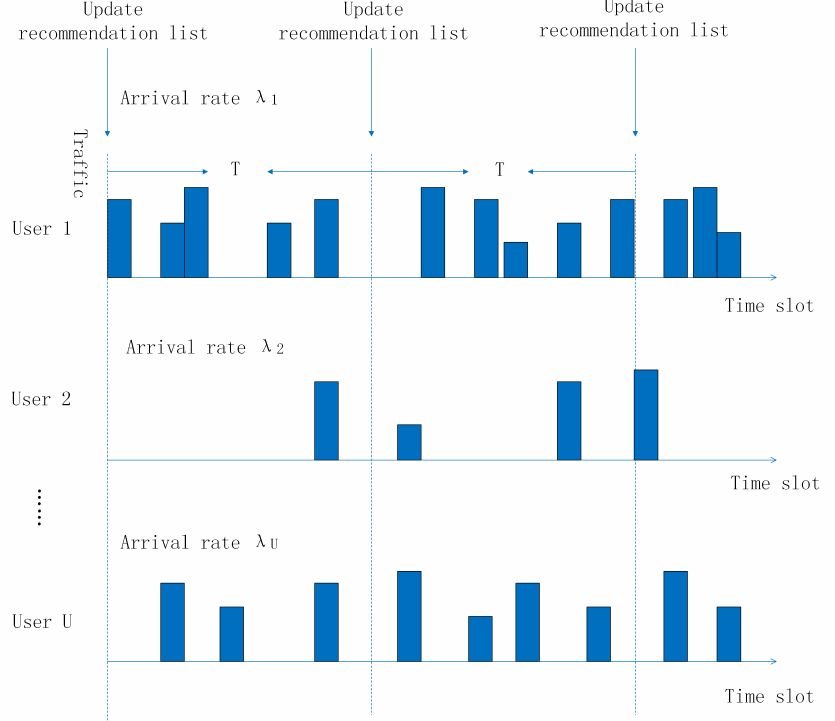
Figure 2. Illustration of the traffic demand